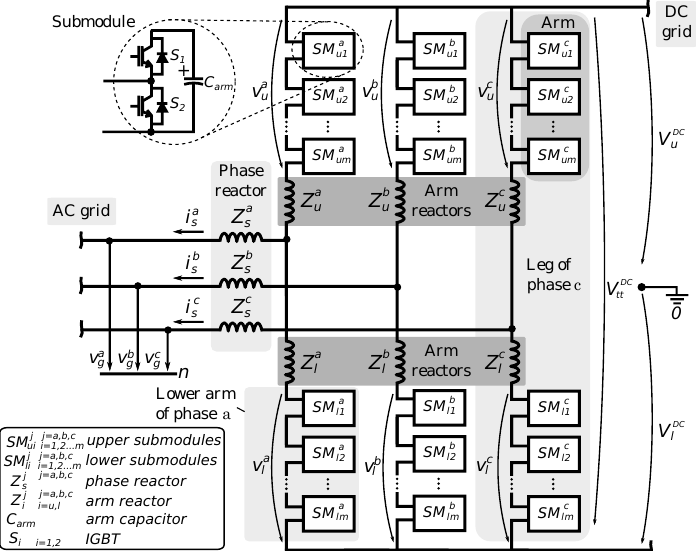
Figure 1. Typical modular multilevel converter scheme.